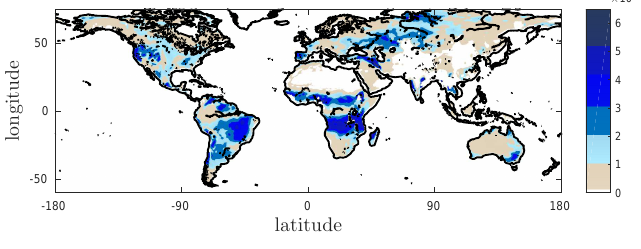
Figure 8. Spatial distribution for variance of the time series for ERA-Interim SM for ascending overpass in the testing